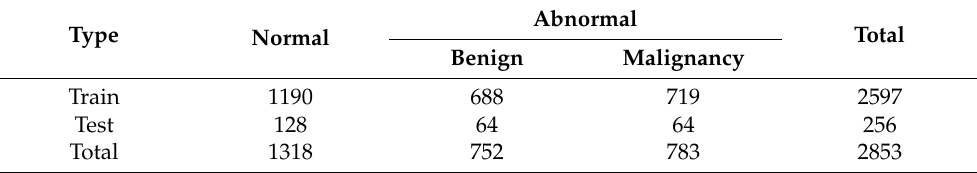
Table 3. Distribution of